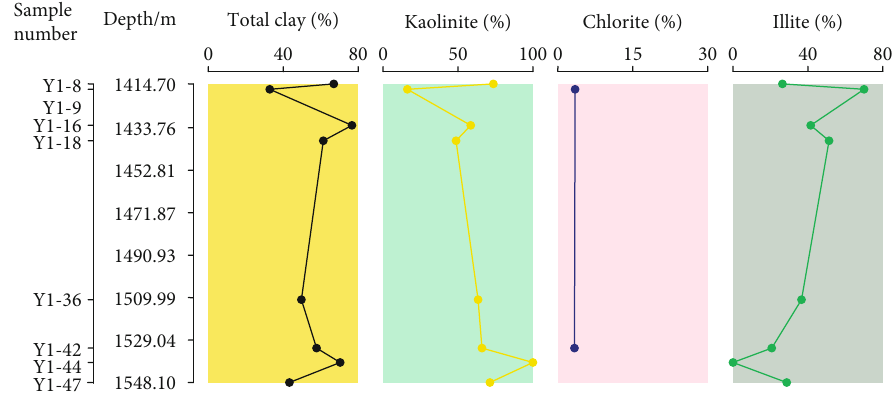
Figure 3: Mineral content of shale reservoir in the Lower Shihezi Formation to Taiyuan Formation of well